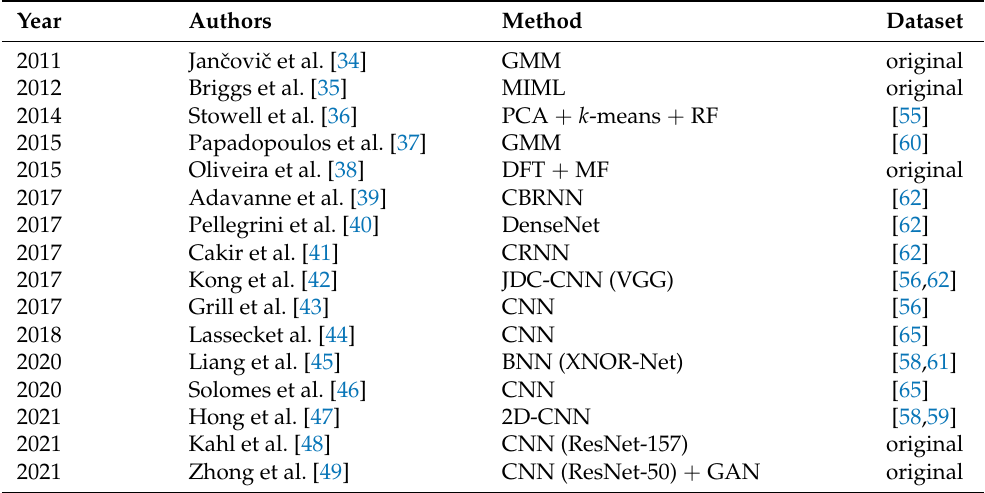
Table 2. Representative studies of sound-based bird detection methods reported during the last